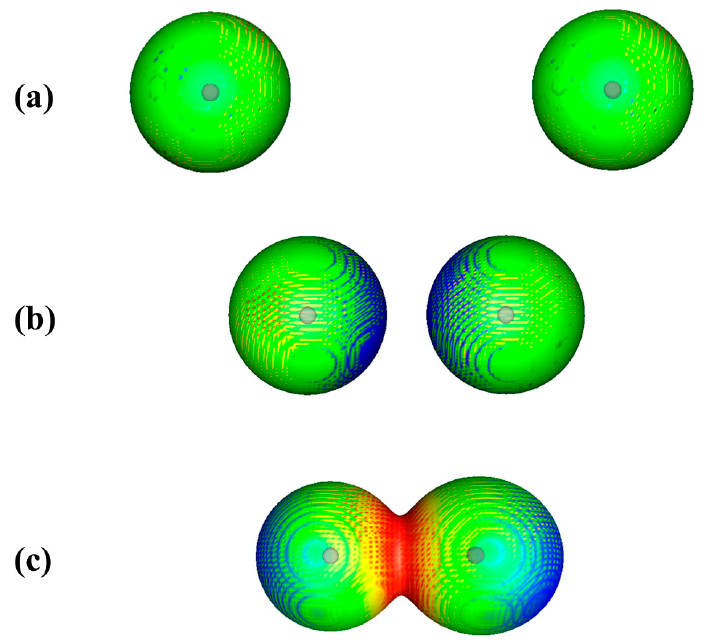
Figure 1. Computed electrostatic potentials on 0.001 au surfaces of two approaching argon atoms. Circles indicate positions of nuclei. Separations are ( a ) 10.0, ( b ) 5.0 and ( c ) 3.758 Å (experimental equilibrium distance). Color ranges, in kcal/mol, are—red, more positive than 2.0; yellow, between 2.0 and 1.9; green, between 1.9 and 1.8; blue, between 1.8 and zero.